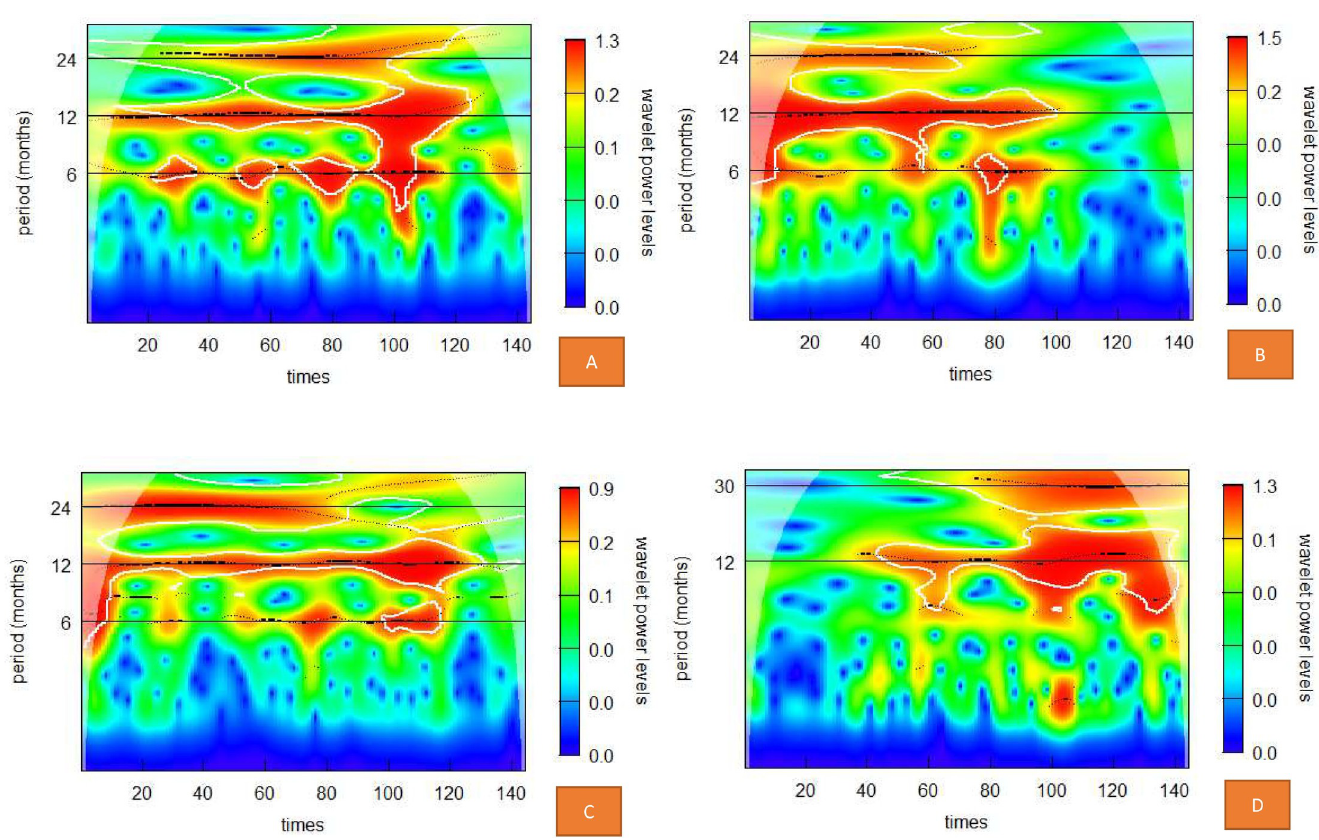
Fig 3. Wavelet spectrum of HFMD for total cases, EV71 cases, Cox A16 cases and other enterovirus cases. (A) Wavelet spectrum of the total case. (B) Wavelet spectrum of the EV71 case. (C) Wavelet spectrum of Cox the A16 case. (D) Wavelet spectrum of other enteroviruses.